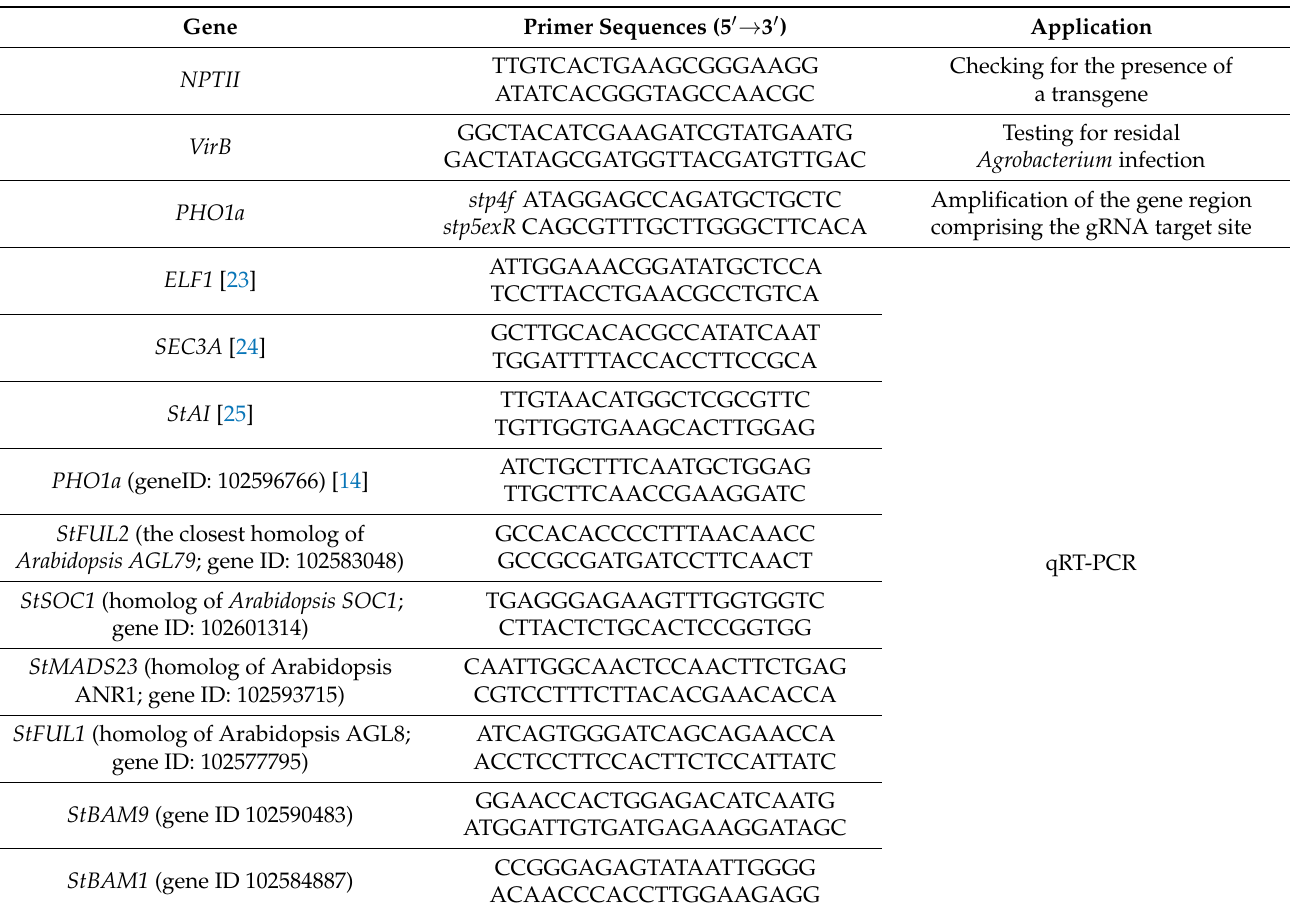
Table 1. List of primers for AsCHI1-7 gene amplification, sequencing, and expression analysis. Gene Primer Sequences (5 (cid:48) → 3 (cid:48)